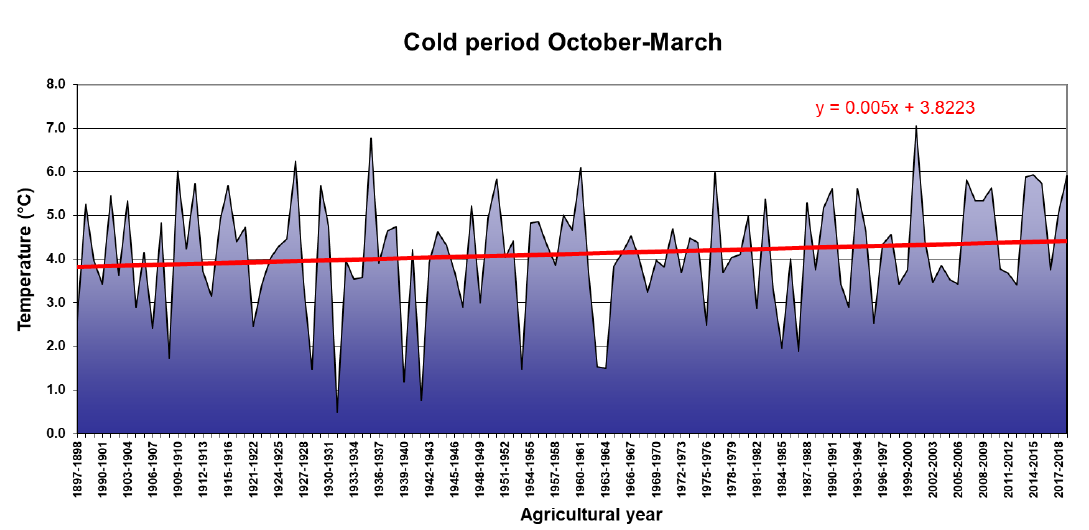
Figure 4. Temperature evolution during the cold period of the year recorded in the Banat Plain, at the Regional Meteorological Center Banat-Crisana during the period 1897 – 2019.